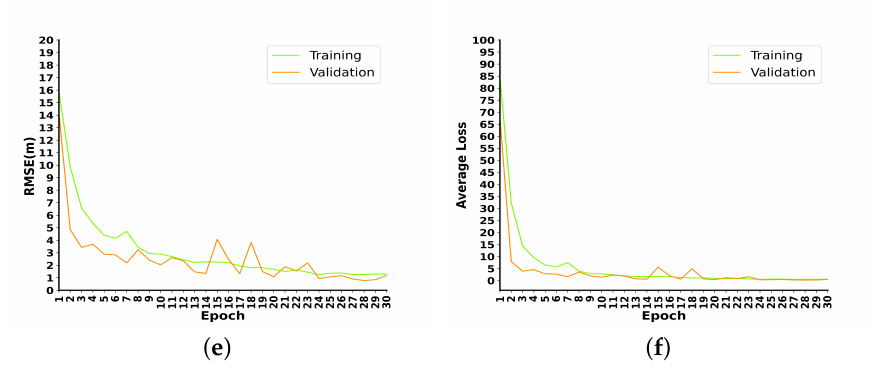
Figure 5. Convergence behavior of the DECC network for the urban canyon scenario ( a , c , e ) and the indoor scenario ( b , d , f ).